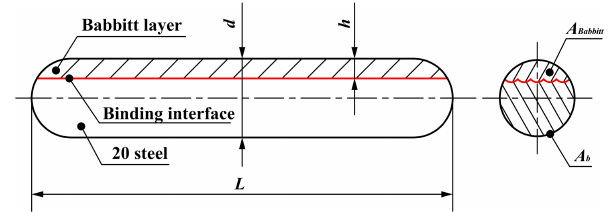
Figure 5. Shape and dimension of specimens for contact-impact testing, with different values of h described in Table 1.